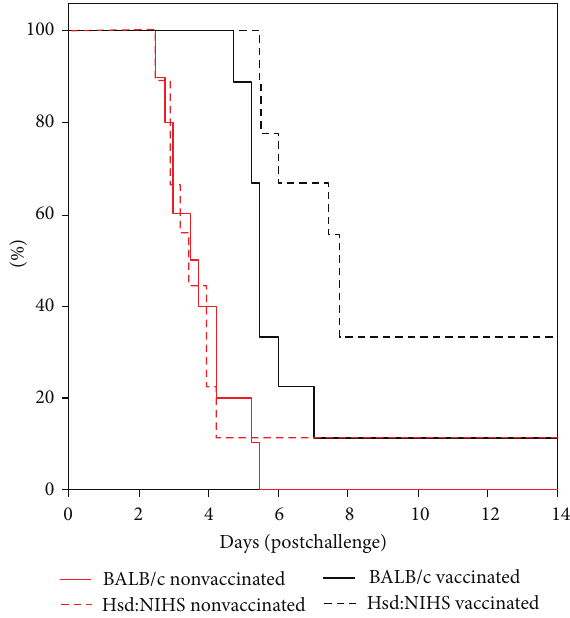
Figure 7: Hsd:NIHS mice had better survival outcomes than BALB/c mice after administration of human serum. Study (5), 𝑛 = 10 mice per group. Mice were injected with 250 𝜇 L human serum into the peritoneal cavity, 3–6 hours before being exposed to aerosolised Y. pestis using a modified contained Henderson apparatus. The MTD was calculated using a Kaplan-Meier survival